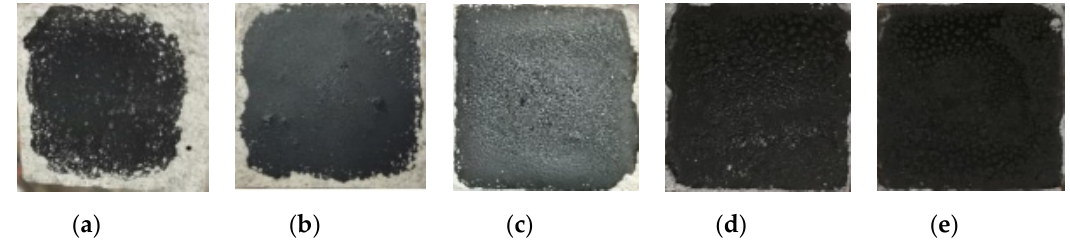
Figure 14. Changes in fracture surface with increased curing age (using S-HV modified asphalt). ( a ) 3 d, ( b ) 7 d, ( c ) 14 d, ( d ) 21 d, ( e ) 28 d.